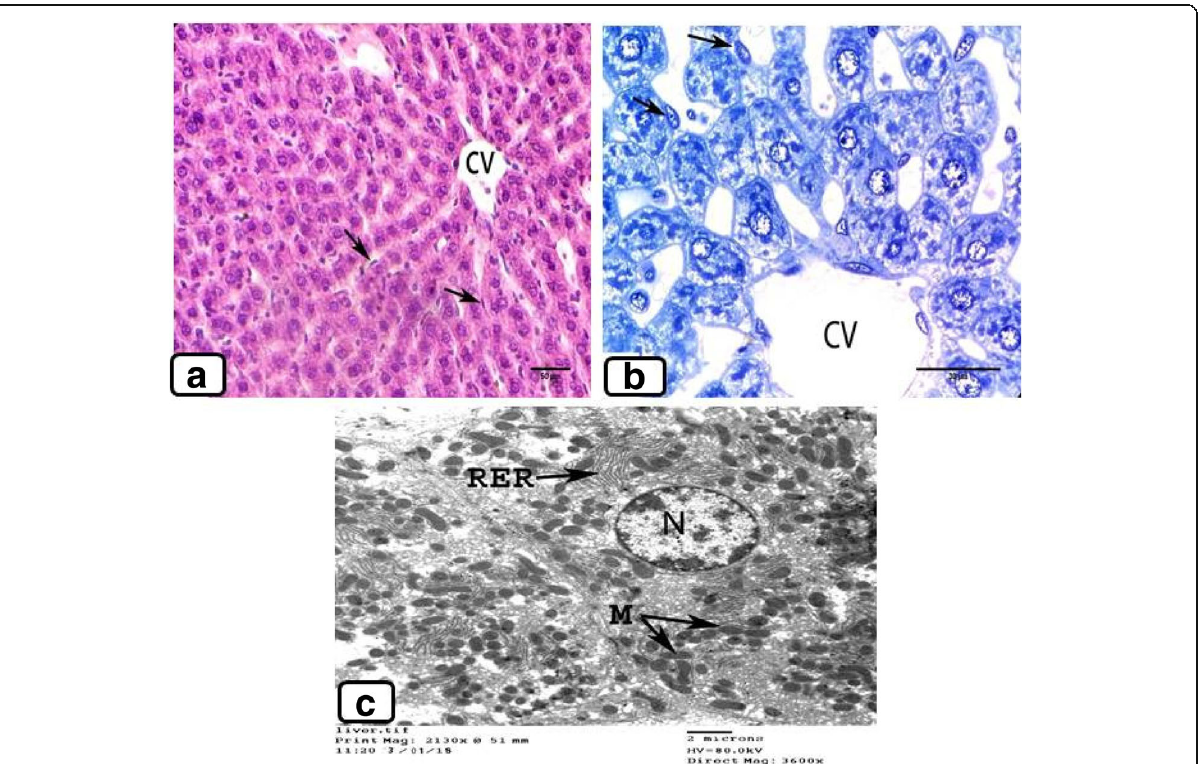
Fig. 2 a Liver section of control rat showing normal polyhedral hepatocytes radiating from the central vein (CV) with eosinophilic cytoplasm and centrally located nuclei. The blood sinusoids are often seen with phagocytic Kupffer cells (arrows) between the cords of hepatocytes (H&E). b Semithin section of control rat liver showing the normal structure of hepatocytes and central vein (CV). Note: Kupffer cells (arrows) (toluidine blue stain). c Electron micrograph of the hepatocyte of control rat showing centrally located rounded nucleus (N), normal distribution of hetero and euchromatin, well-developed rough endoplasmic reticulum (RER), and mitochondria with dense matrices and vary in shape